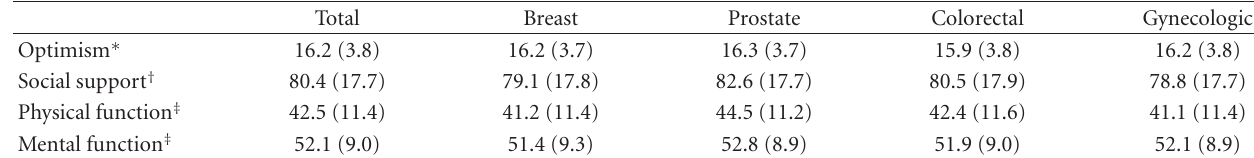
Table 2: Unadjusted mean scores and standard deviations for psychosocial/HRQOL